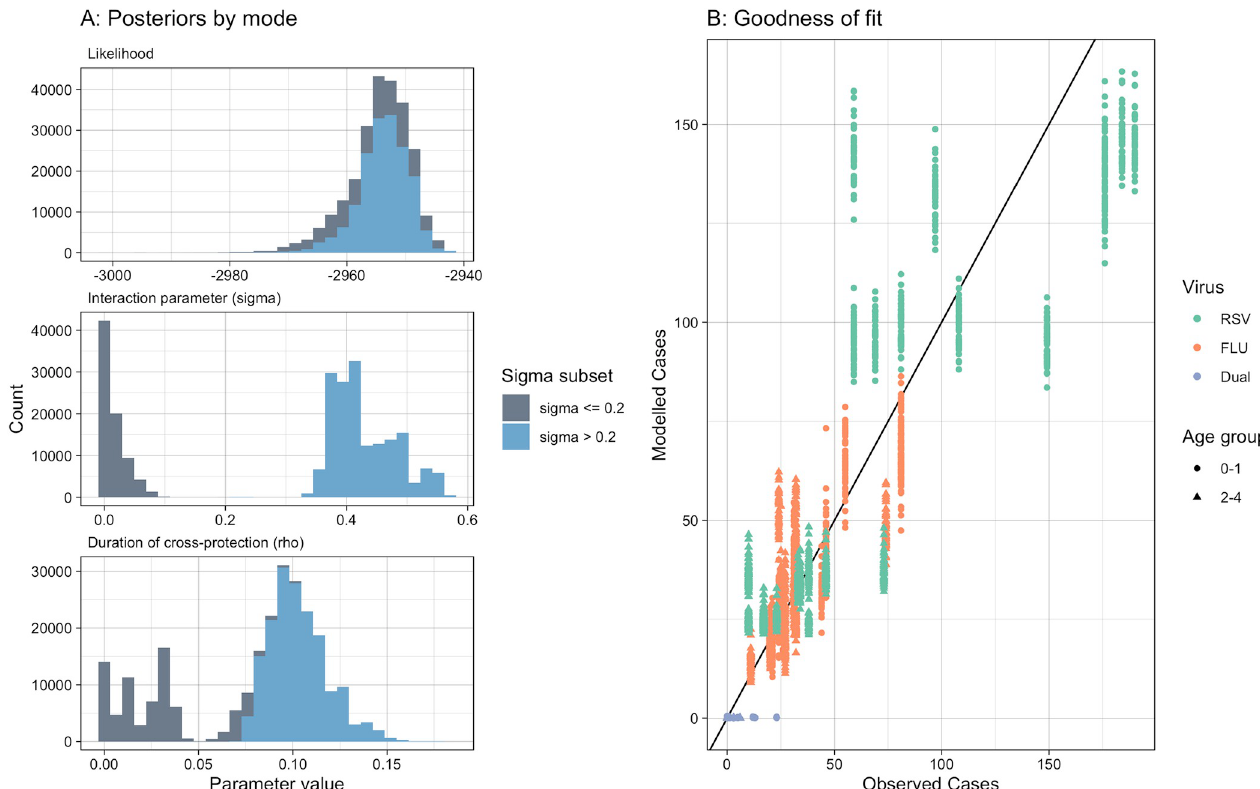
Fig 3. Posterior estimates for parameters sigma and rho, and the corresponding likelihood values. Colour is split by sigma value of 0.2. B) Goodness of Fit: Observed cases by season against Modelled cases by season by virus and age group. The black line indicates the same value.